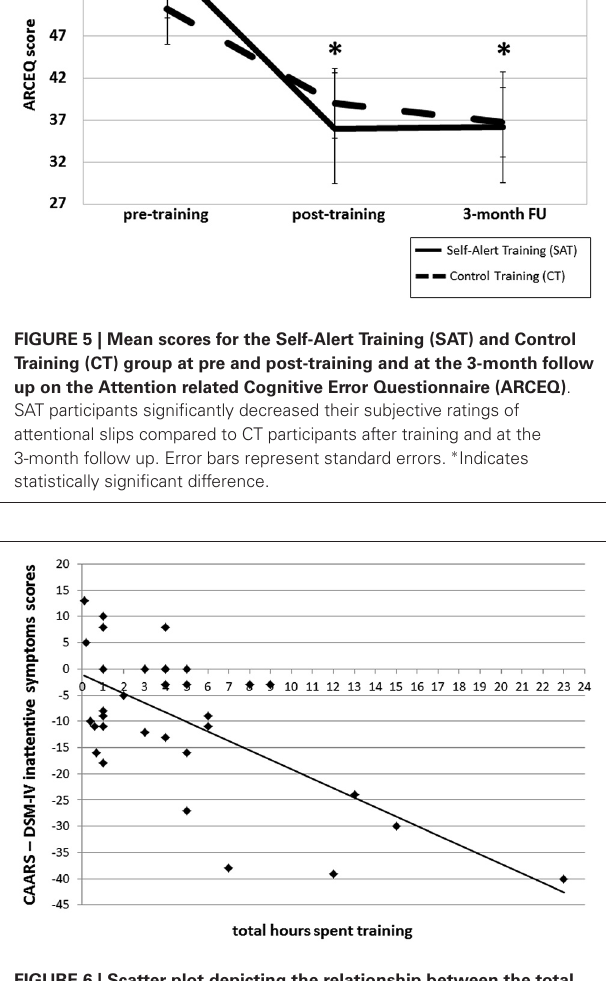
FIGURE 6 | Scatter plot depicting the relationship between the total number of hours spent training and proportional reduction in DSM-IV Inattentive Symptoms scores for SAT participants